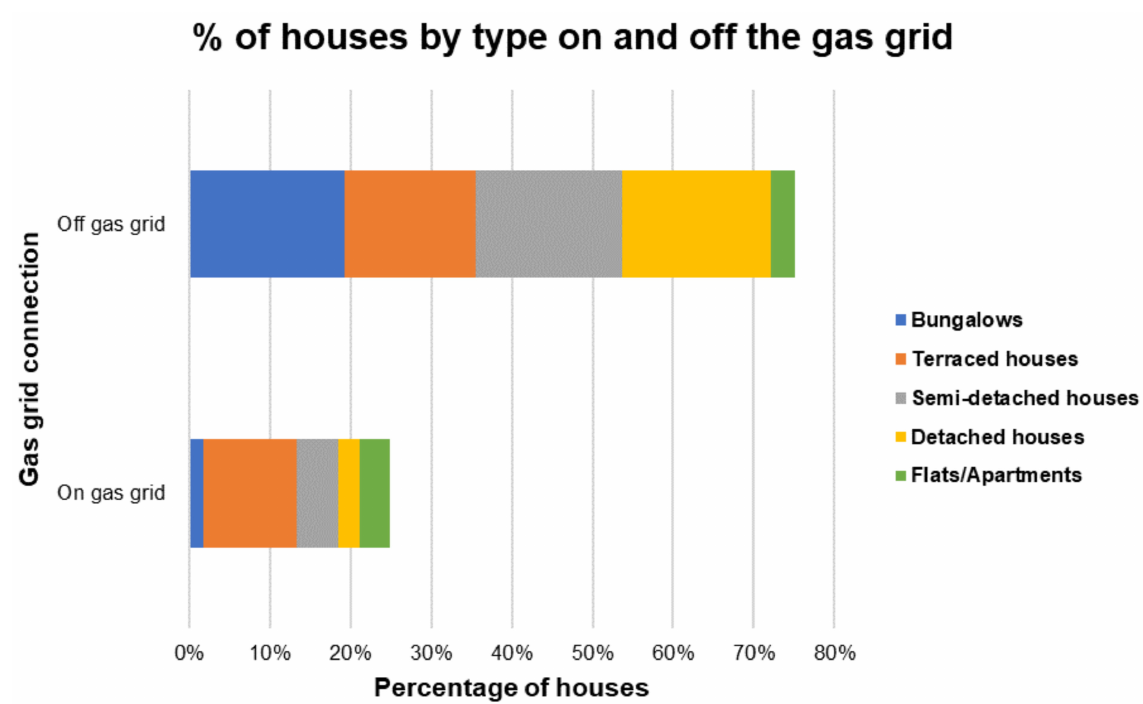
Figure 3. Breakdown of house archetypes based on gas heating